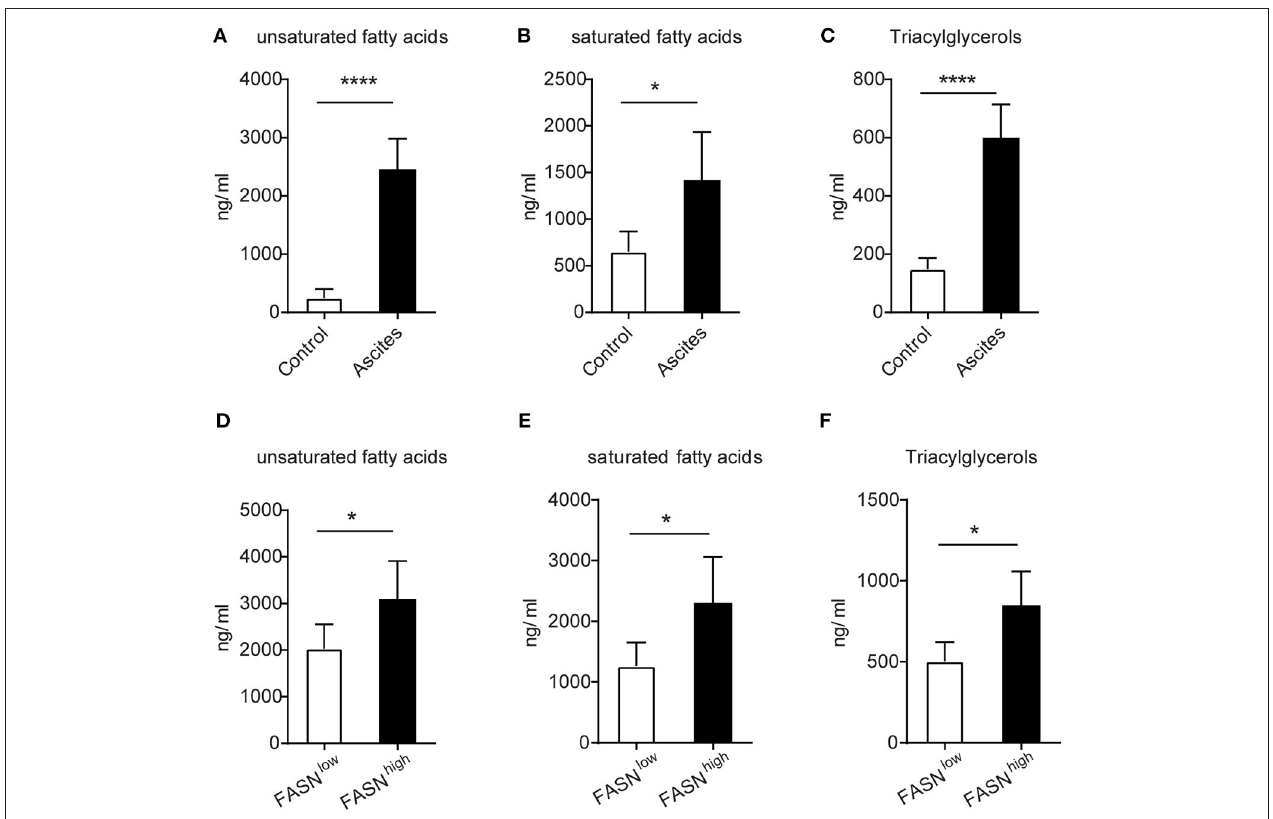
FIGURE 4 | The enrichment of lipids in the FASN-high ovarian tumor microenvironment. (A–C) The supernatants of malignant ascites were collected from ID-8 tumor-bearing mice after 3 weeks. The normal peritoneal fluid was collected from naive C57BL/6J mice. The amount of fatty acids and triacylglycerols were quantitatively analyzed via LC-MS. Depicted are total unsaturated fatty acids (A) , saturated fatty acids (B) , and triacylglycerols (C) . (D–F) C57BL/6J mice were intraperitoneally injected with 5 × 10 5 FASN low or FASN high ID8 cells, and supernatants of malignant ascites were collected after 3 weeks. Fatty acids and triacylglycerols were extracted and quantitatively analyzed by LC-MS. Depicted are total unsaturated fatty acids (D) , saturated fatty acids (E) , and triacylglycerols (F) . Data = mean ± SEM; representative of 2 independent experiments; * P < 0.05; **** P <